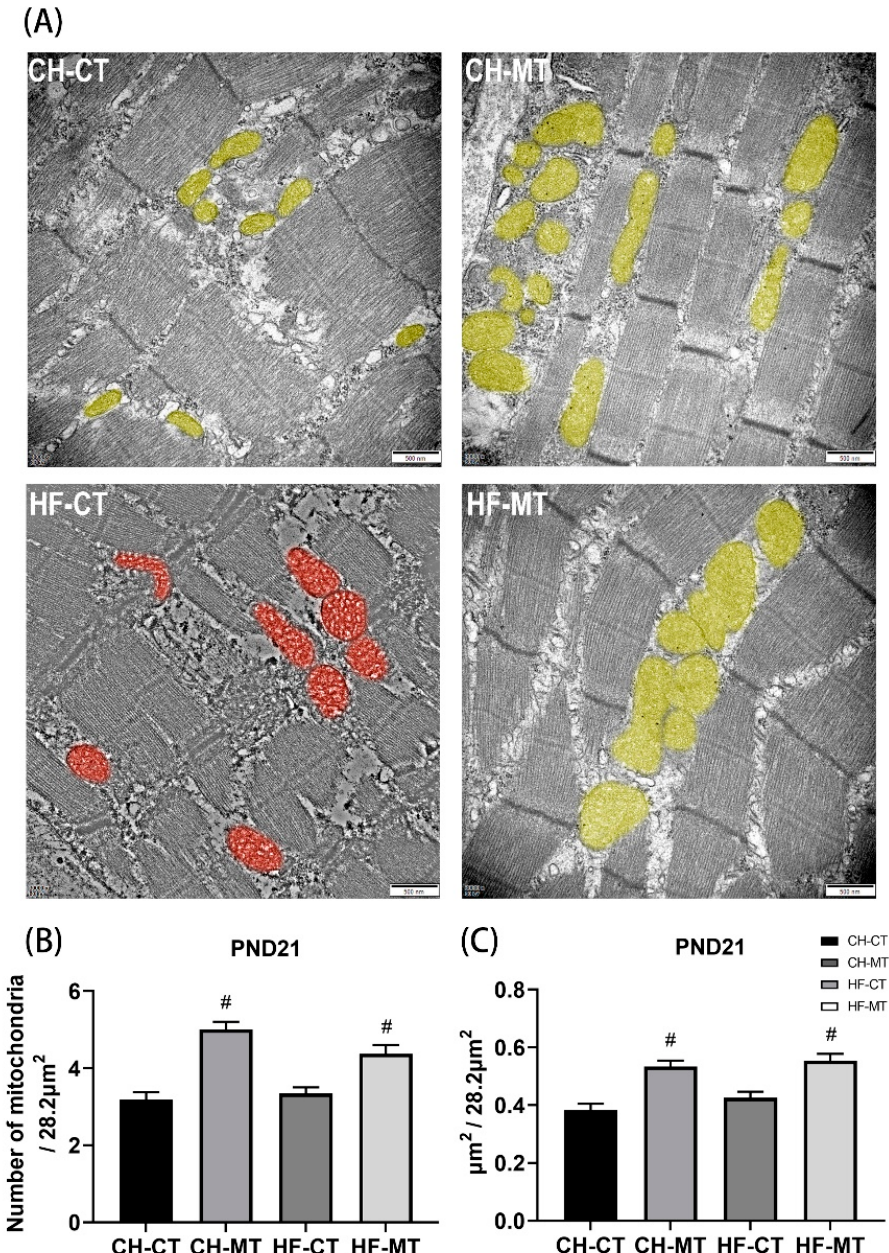
Figure 5. Transmission electron micrographs of skeletal muscle in PND21 male offspring. ( A ) Repre- sentative transmission electron micrographs. Mitochondria were artificially colored. Mitochondrial number ( B ) and average volume ( C ) per vision (28.2 µ m 2 ) were measured. Scale bar = 500 nm. Data are expressed as mean ± S.E.M (n = 4–5 per group). Data were analyzed by two-way ANOVA, # main effect of maternal metformin, p < 0.05 versus control.